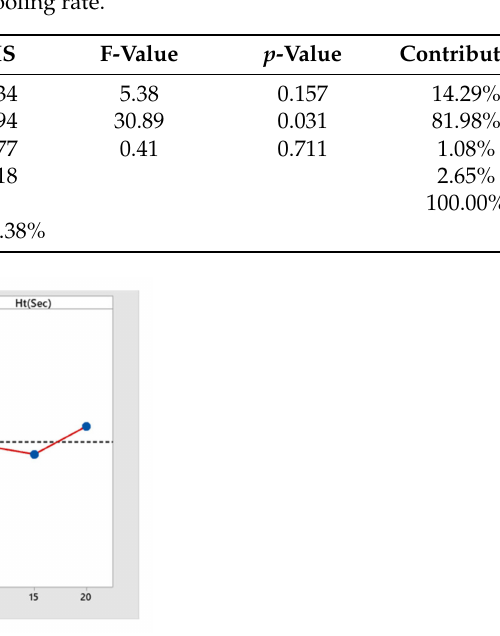
Table 5. ANOVA table for the cooling rate.